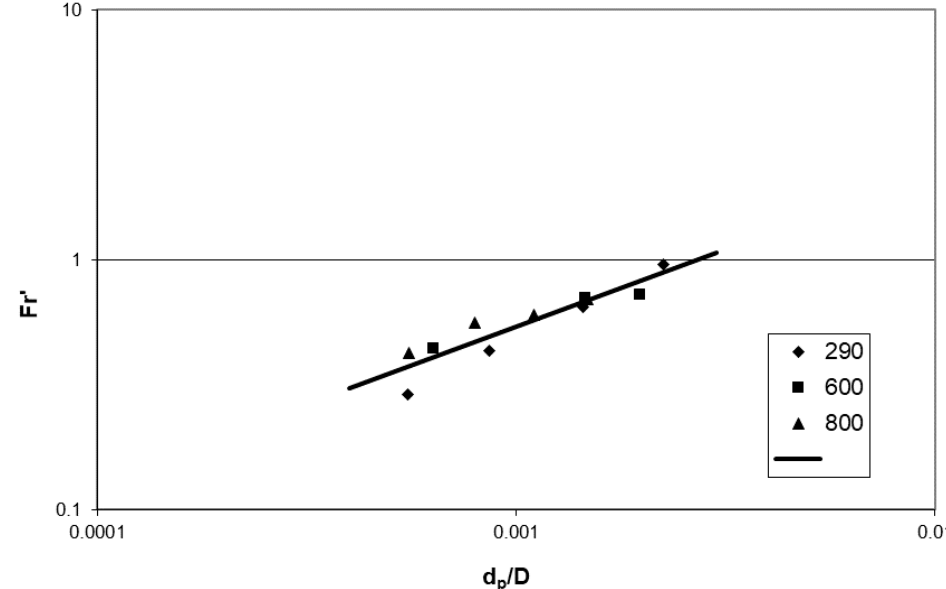
Figure 7. Dependence of Fr´ on relative particle size for pitched, four-blade turbines for mean volumetric concentration of particle 10%.